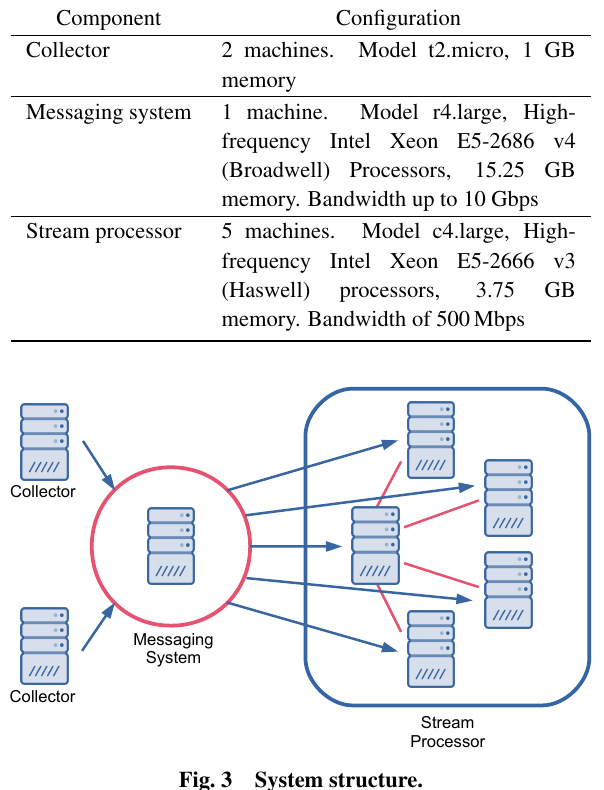
Table 2 Configurations for each component. Component